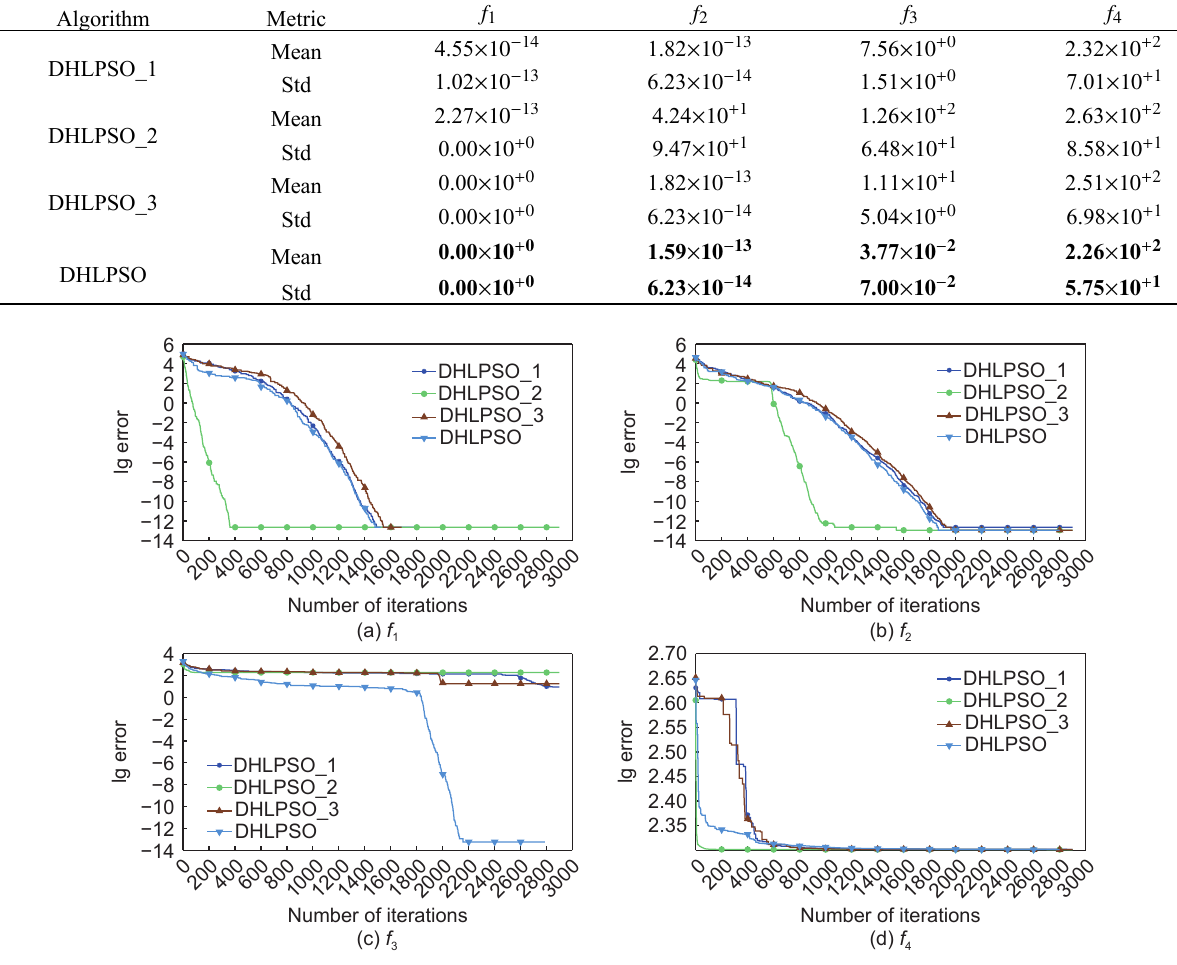
Fig. 5 Convergence curves of the four